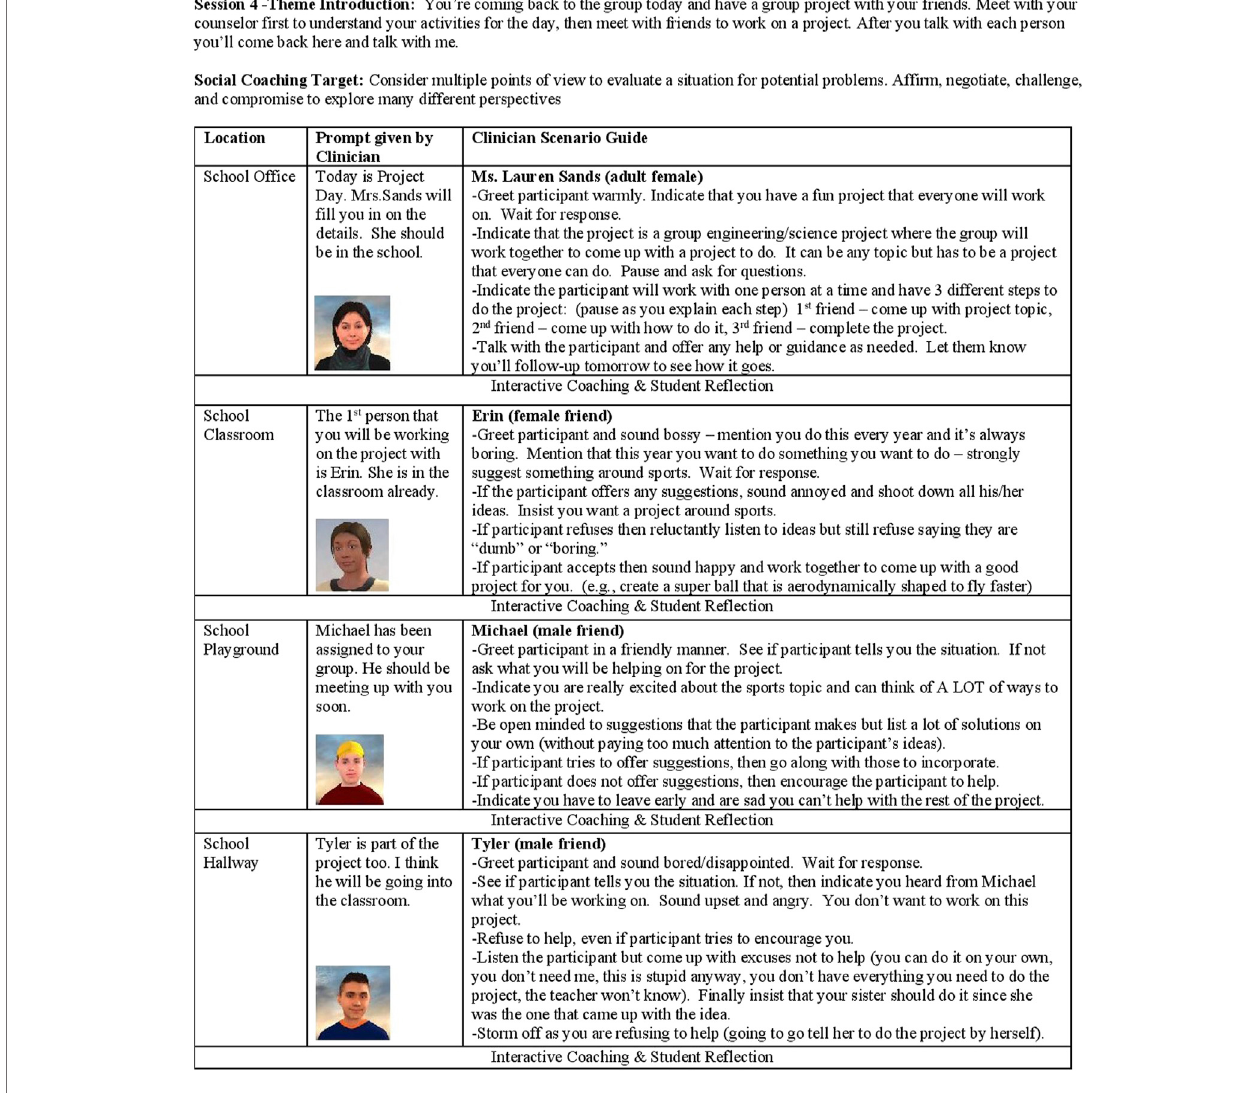
FIGURE 4 | Confederate-clinician/faux peer scenario guide- session